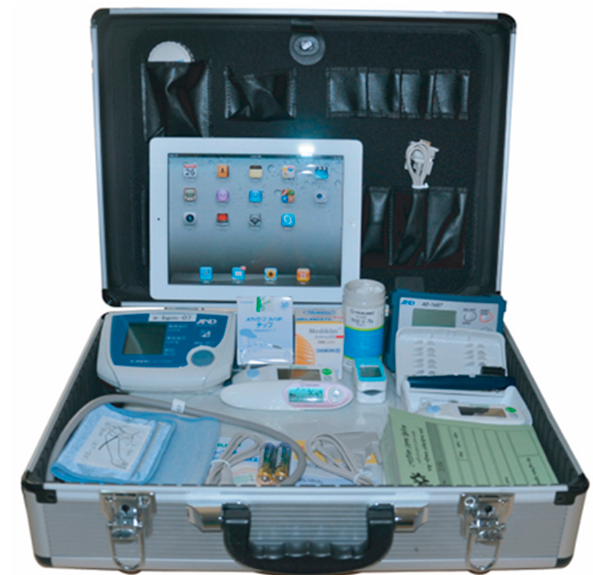
Figure 2. Portable health clinic (PHC) box with different medical sensors.